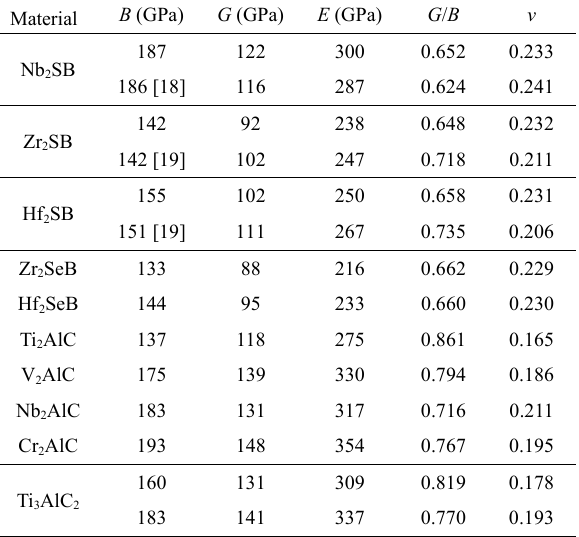
Table 3 Elastic properties, Pugh’s ratios ( G / B )